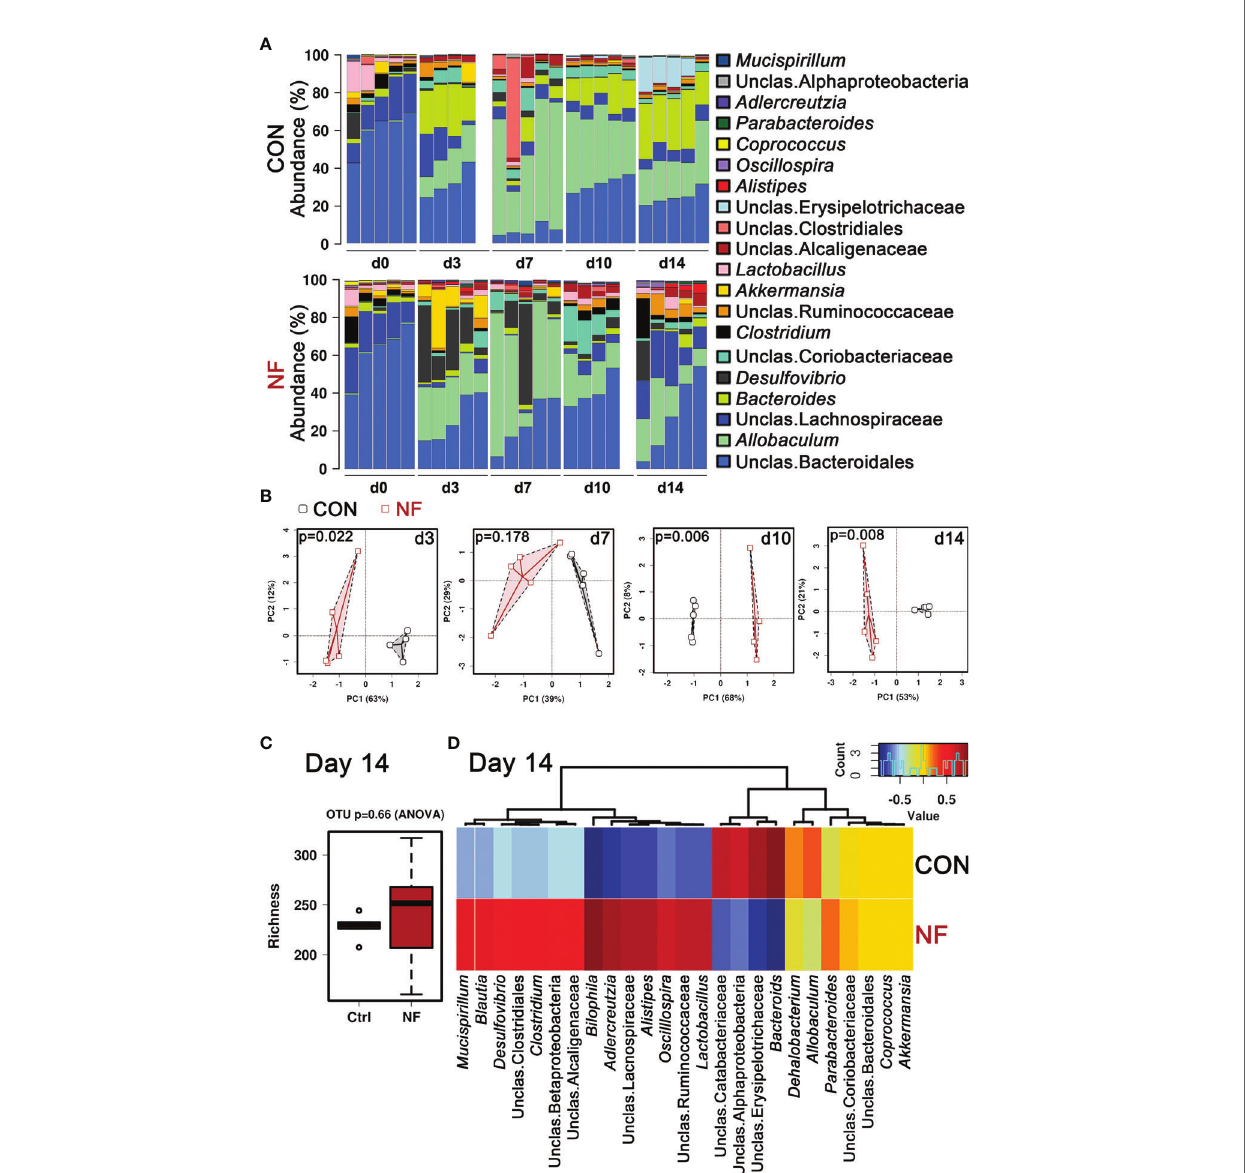
FIGURE 1 | No- fi ber diet feeding modi fi es gut microbiota. WT mice were fed either a control (CON) or no fi ber (NF) diet for 14 days. At days 0, 3, 7, 10, or 14 of diet, fecal samples were collected and 16S rRNA sequencing performed. (A) The abundance (%) of the top 20 bacteria at the genera level. (B) Principle coef fi cient analysis (PCA) of CON and NF groups at the OTU level, and Adonis UniFrac was performed. At day 14, the diversity of the gut microbial composition was quanti fi ed by analysis of richness (C) and Pearson ’ s correlation at the genera level were performed (D) . Dots represent individual mice, N ≥ 4 per time point per diet